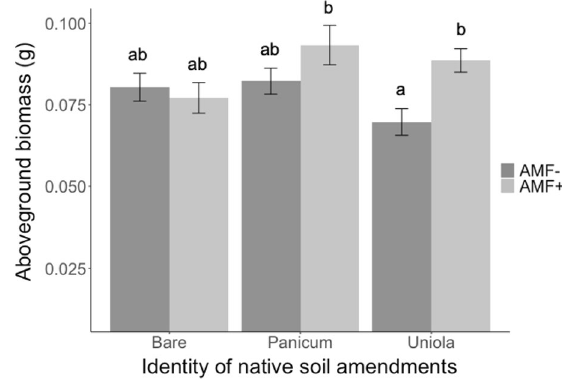
Figure 1. Effect of native soil amendment identity and the presence of commercial AM fungi (AMF−, AMF +) on the aboveground biomass of P. amarum. Bars indicate treatment means ± SE. Letters denote significant differences between each combination of soil amendment identity and AM fungi treatment estimated using linear models (P < 0.05).